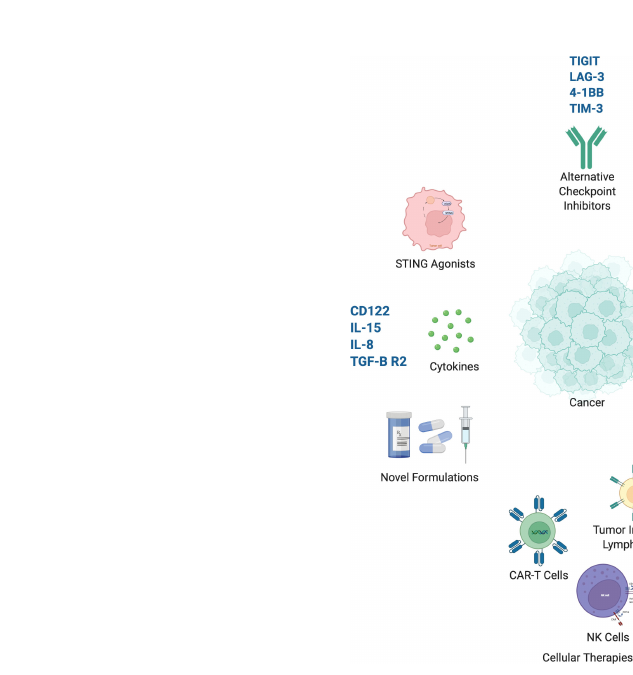
FIGURE 1 Select emerging immunotherapies currently in clinical development. Created with